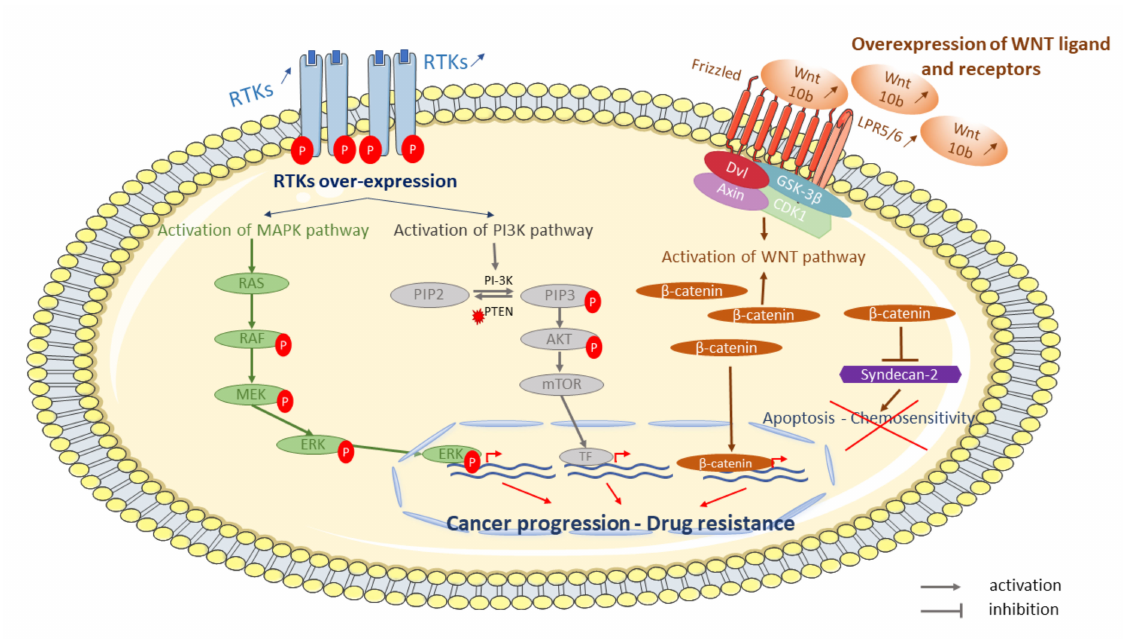
Figure 2. Some examples of signaling pathways involved in OS resistant tumor cells to conventional treatment. Cell surface- receptors, such as tyrosine kinase receptors (RTKs), are disturbed in resistant cells to chemotherapy. Over-expression and phosphorylation of RTKs activate signaling pathways such as mitogen-activated protein kinases (MAPK) or phosphoinositol 3-kinase (PI3K)-protein kinase signaling pathway. Activation of MAPK and/or PI3K leads to proliferation and survival, respectively. Several WNT ligands (WNT 10b) and receptors (lipoprotein receptor-related protein 5—LRP5) and β -catenin are over-expressed and activate the WNT/ β -catenin pathway leading to β -catenin overexpression. β -catenin is able to repress syndecan-2 leading to inhibition of apoptosis and